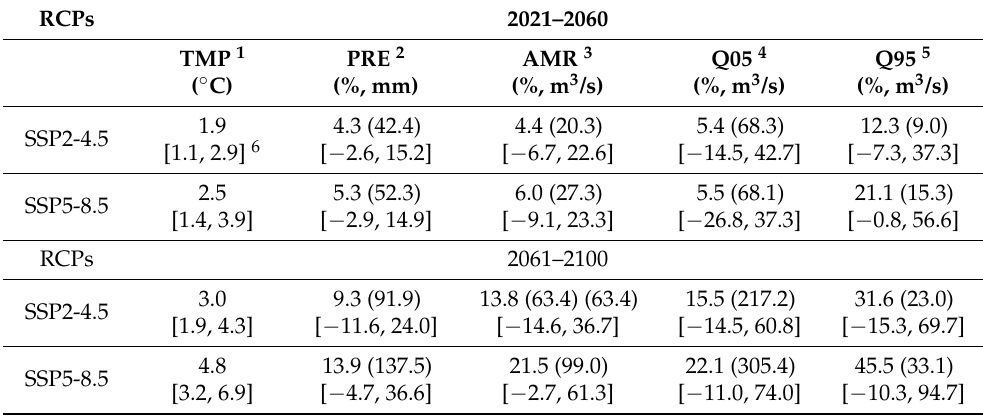
Figure 4. Projected changes in ( a ) monthly average temperature and ( b ) monthly precipitation in the Fujiang River basin for 2021 – 2060 and 2061 – 2100 under 14 GCMs and 2 SSP-RCPs (relative to 1971 – 2010). 3.2. Simulated Changes in Annual and Monthly Runoff Figure 5 shows the simulated changes in annual runoff in the Fujiang River basin. The simulated changes in the ensemble mean of annual runoff show an increase, with the